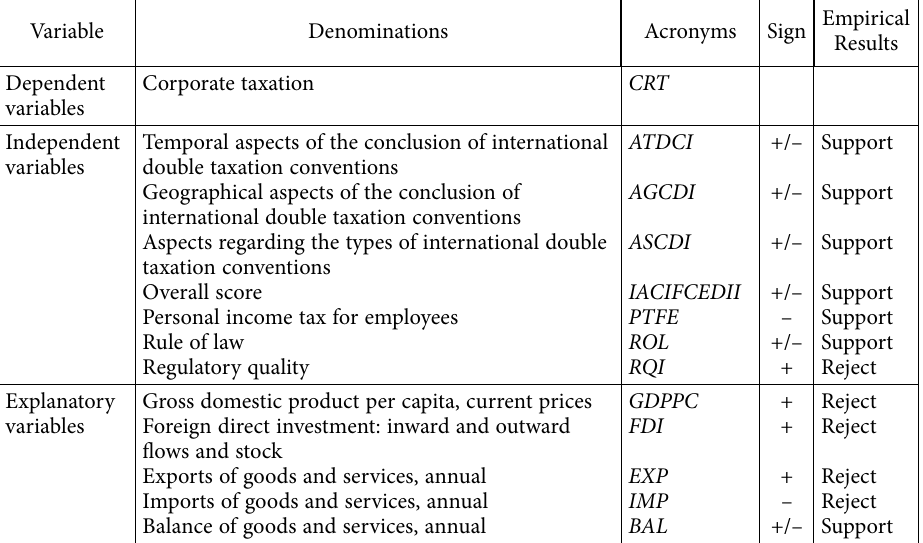
Table 14. Derived signs of the independent and explanatory variables in equation and validation by the empirical results – Eq. (1) (source: own processing) Variable